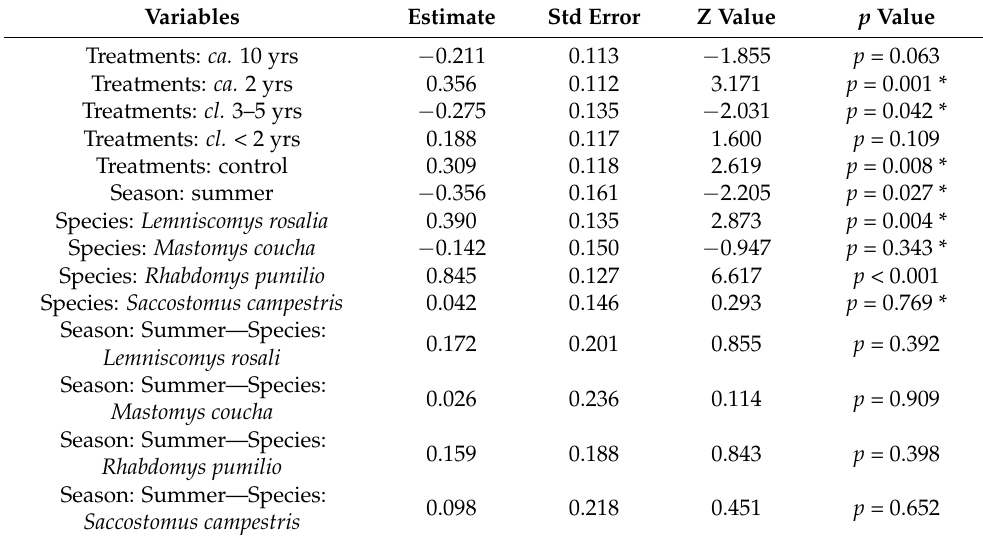
Table 6. Output of a GLMM model for comparisons of the weight of the rodents by treatments, seasons, and species. Significant predictors are shown with